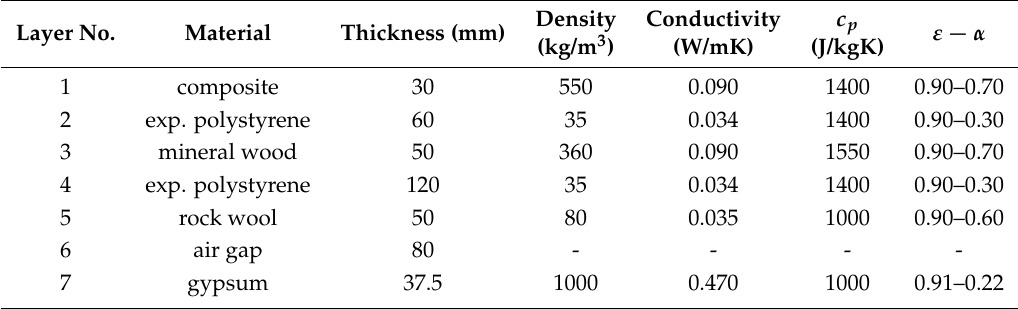
Table A5. Case E: light wall with 7 layers, “PL2” (Layer 1 is outdoors). Thickness: 428 mm. Layer No.